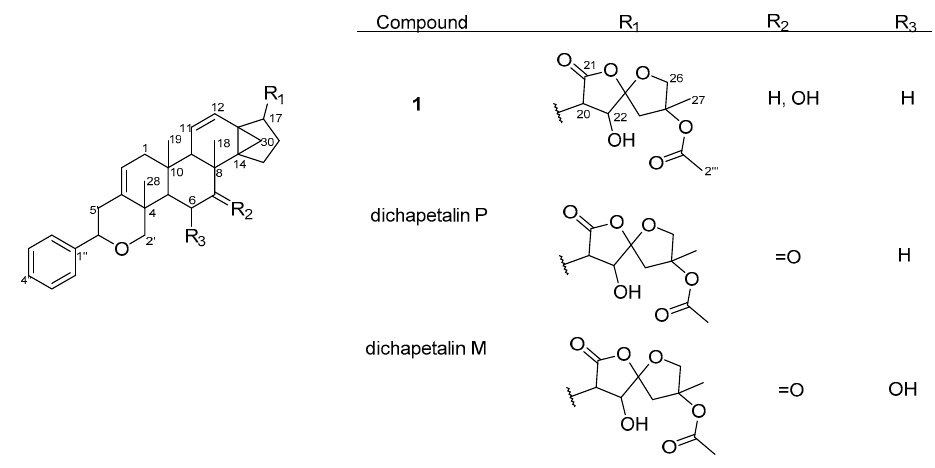
Figure 3. Structures of compound 1 and dichapetalins P and M.